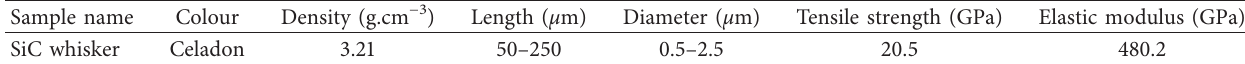
Table 3: Properties of silicon carbide whisker.